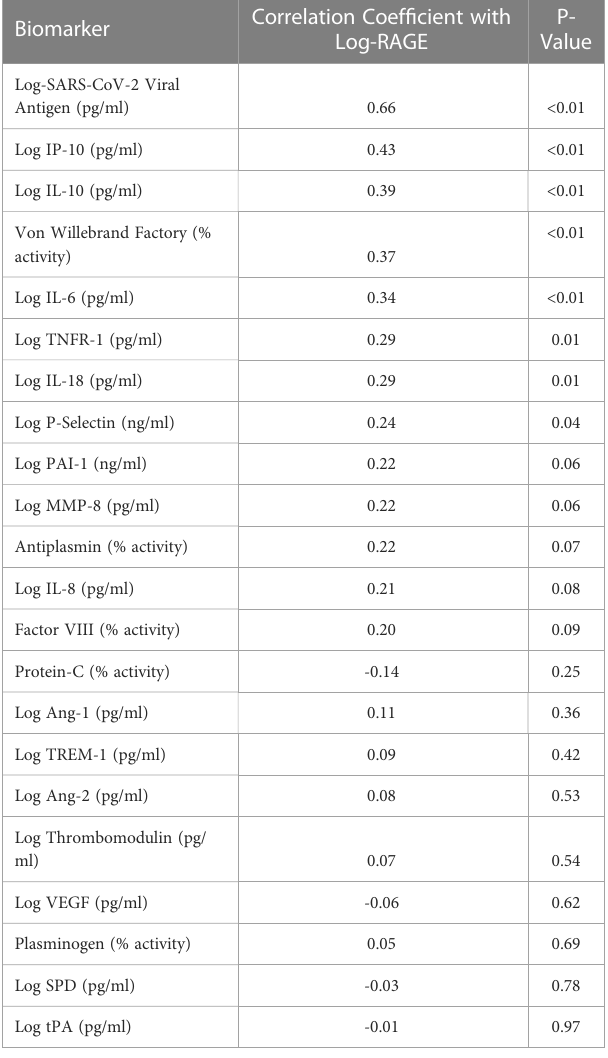
TABLE 6 Spearman correlation coef fi cients of thromboin fl ammatory biomarkers with RAGE.